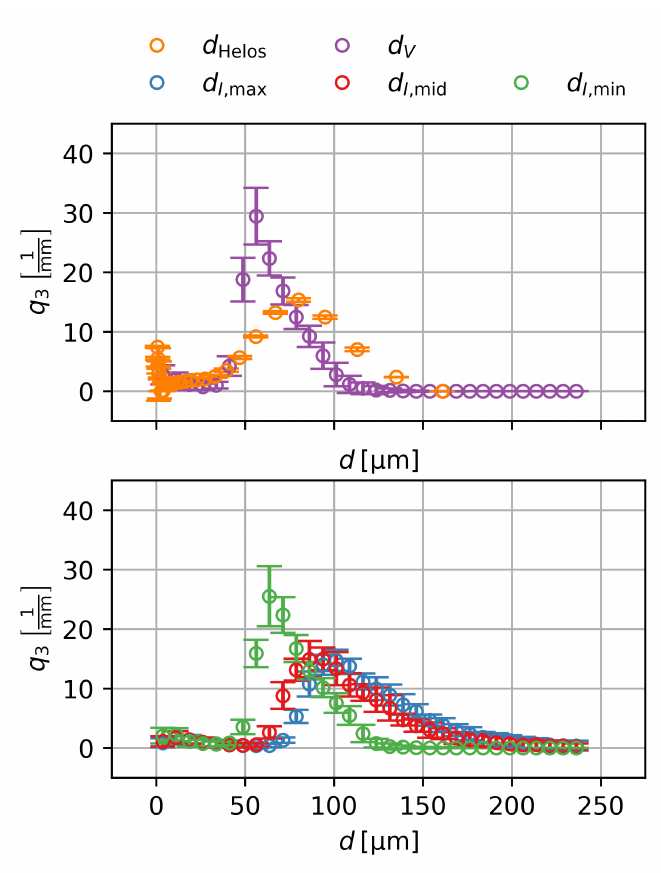
Figure 3. Particle size distributions of the diameters obtained by laser scattering ( d Helos ), of the equivalent spherical diameters ( d V ), as well as of the diameters obtained through image moments ( d I ,max , d I ,mid and d I ,min